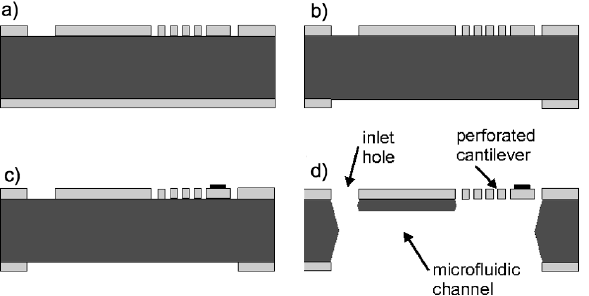
Figure 4. Fabrication sequence for the SiN devices: ( a ) Patterning of perforated cantilevers in the SiN layer on the front side of the wafer. ( b ) Patterning of etch mask for microfluidic channel in the SiN layer on the back side of the wafer. ( c ) Patterning of metal pad at apex of the cantilever. ( d ) Definition of microchannel and release of the SiN devices in KOH.